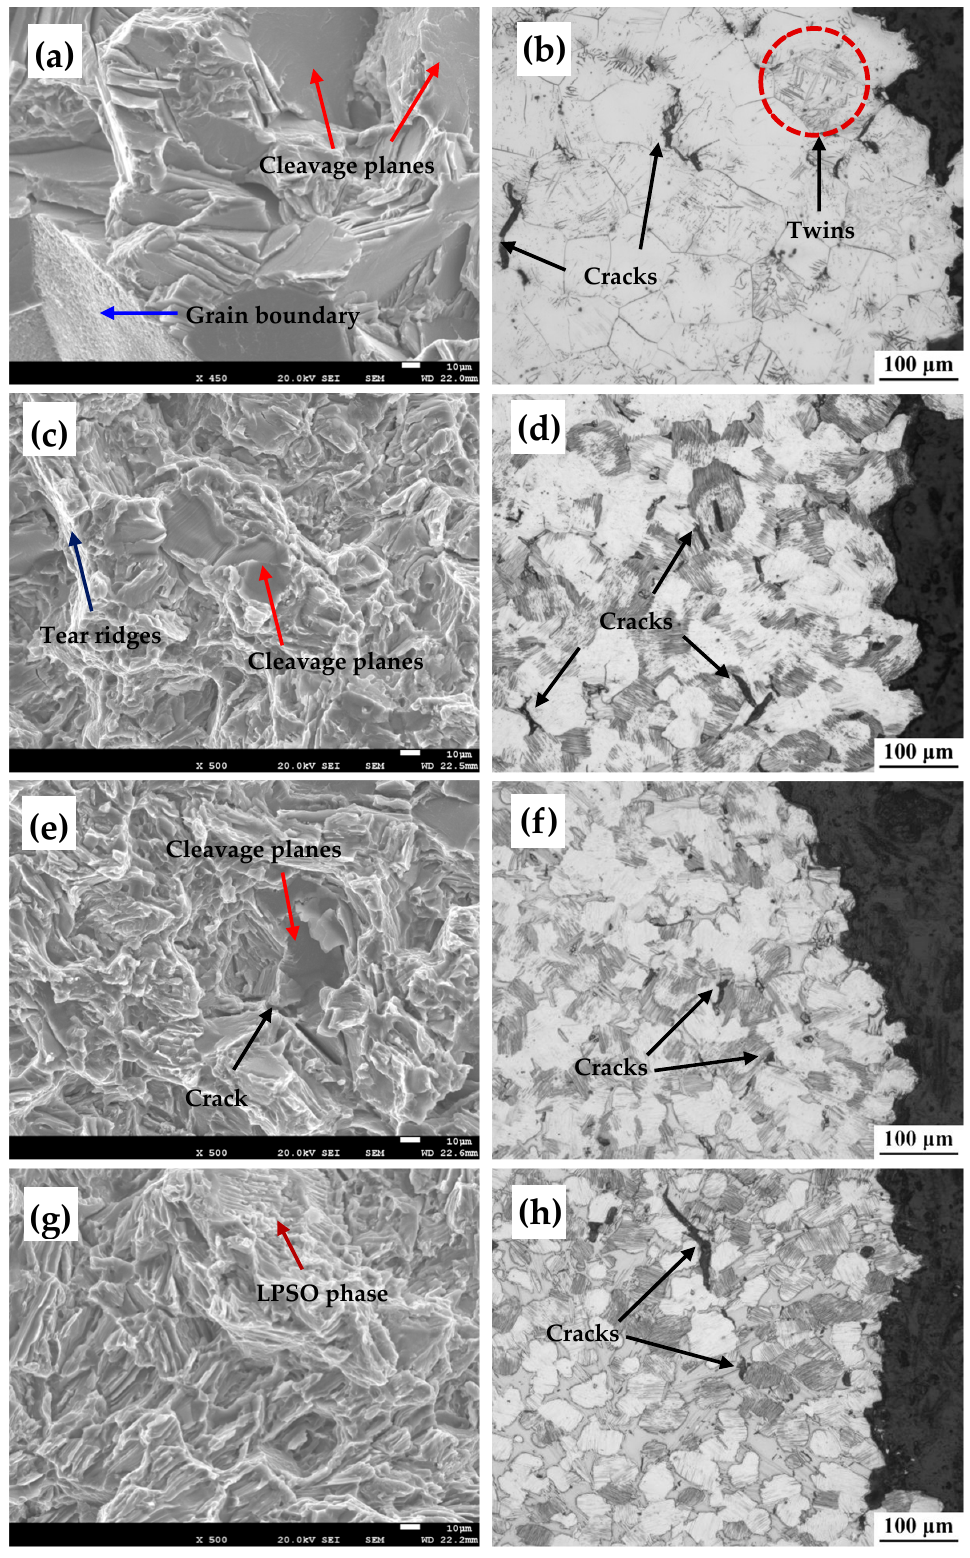
Figure 7. Tensile fracture surface and microstructure near the fracture surface of the alloy: ( a , b ) 0Zn, ( c , d ) 0.7Zn, ( e , f ) 1.5Zn, and ( g , h )